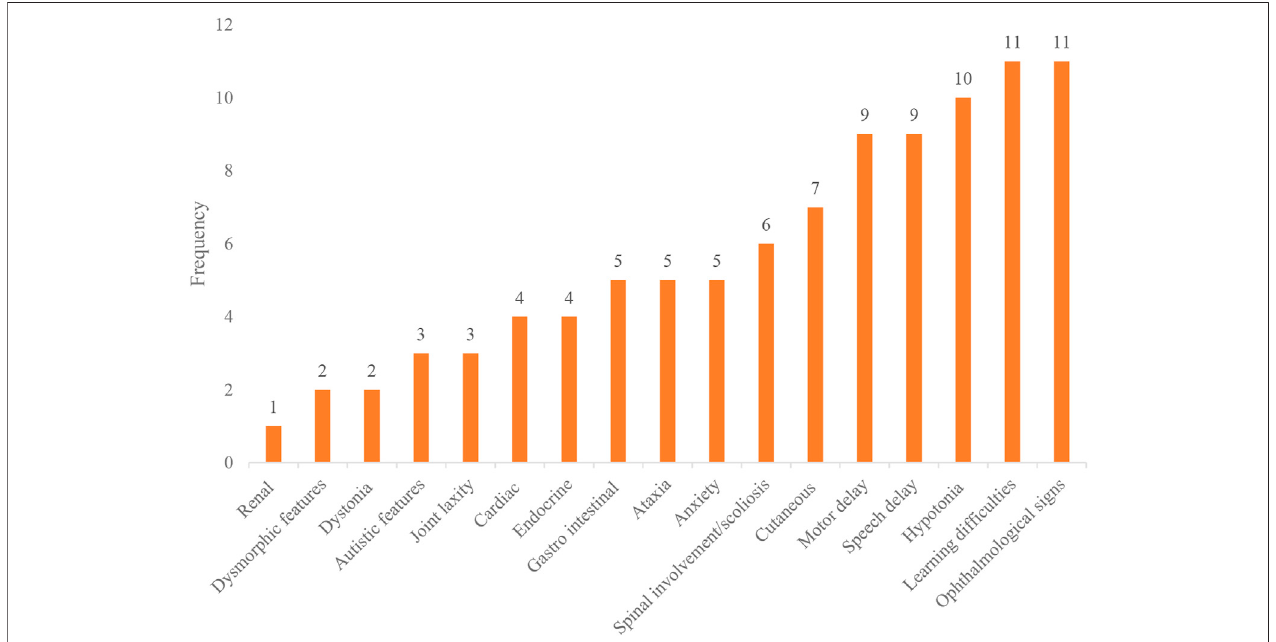
FIGURE1| FrequencyofsymptomsaffectingourSRD5A3-CDGcohort.Thisbarchartdemonstratesthenumberofpatientsaffectedbyeachclinicalfeature/organ involvement. Learning dif fi culties (11/11), ophthalmological signs (11/11), hypotonia (10/11), speech delay (9/11), motor delay (9/11), cutaneous (7/11), scoliosis (6/11), anxiety (5/11), ataxia (5/11), gastrointestinal (5/11), cardiac (4/11), endocrine (4/11), autistic features (3/11), joint laxity (3/11), dystonia (2/11), dysmorphism (2/11), and renal (1/11).